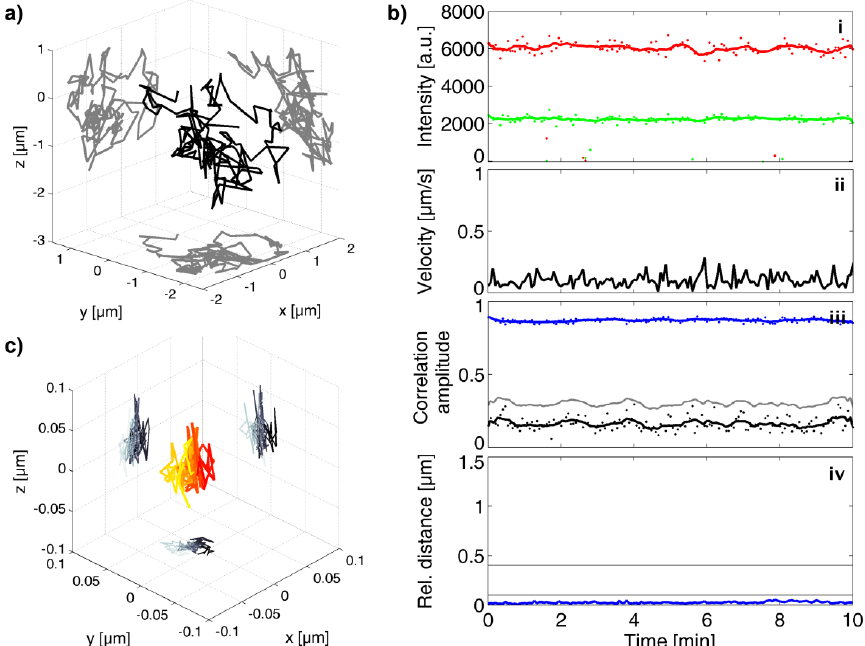
Figure A4. TrIC analysis on a dual-color fluorescent bead. As a positive control, we measured the diffusion of a dual-color fluorescent bead in a glycerol solution. ( a ) The 3D-trajectory and 2D-projections of a tracked bead. ( b ) The corresponding TrIC analysis: ( i ) The background-corrected fluorescence intensity of the green and the red signal are plotted as a function of time. ( ii ) The instantaneous velocity is plotted as a function of time. ( iii ) The amplitude of the cross-correlation of the TrIC analysis for the data (blue), the randomized control (black) and threshold (grey) are plotted as a function of time. ( iv ) The relative distance between the eGFP-capsid and mCherry-Env signal is plotted over time. ( c ). A 3D-representation of the relative position of the red signal with respect to the green signal color-coded as a function of time. The results show a high correlation amplitude and a relative distance of less than 100 nm over the whole trajectory.